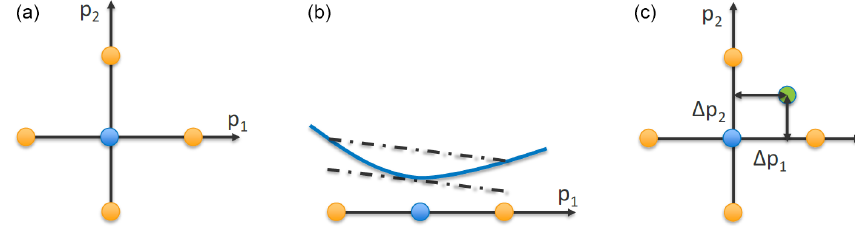
Figure 2. Visualization of the interpolation method for the case with two parameter variations. (a) Nominal (operating) parameter point in blue and the bounds of the parameter interval in orange. (b) Slope (shown as the dashed–dotted line) of the state-space matrix values (shown as a continuous blue function) computed using finite differences from the bounds. (c) Interpolation